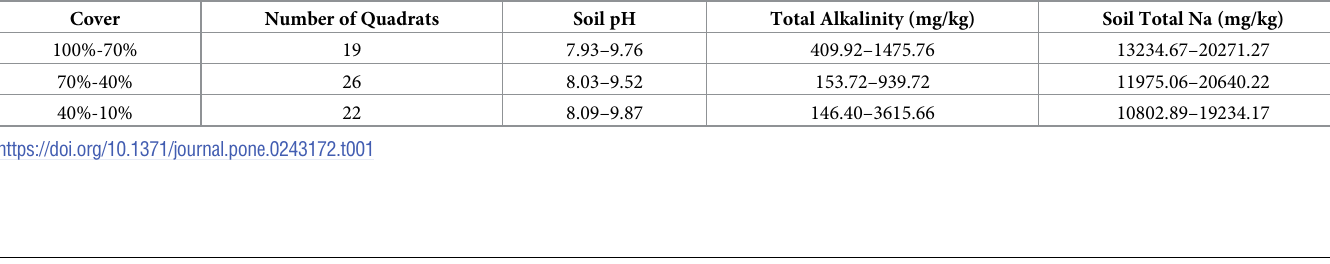
Table 1. Soil pH, total alkalinity and total Na of sampling sites. Cover Number of Quadrats Soil